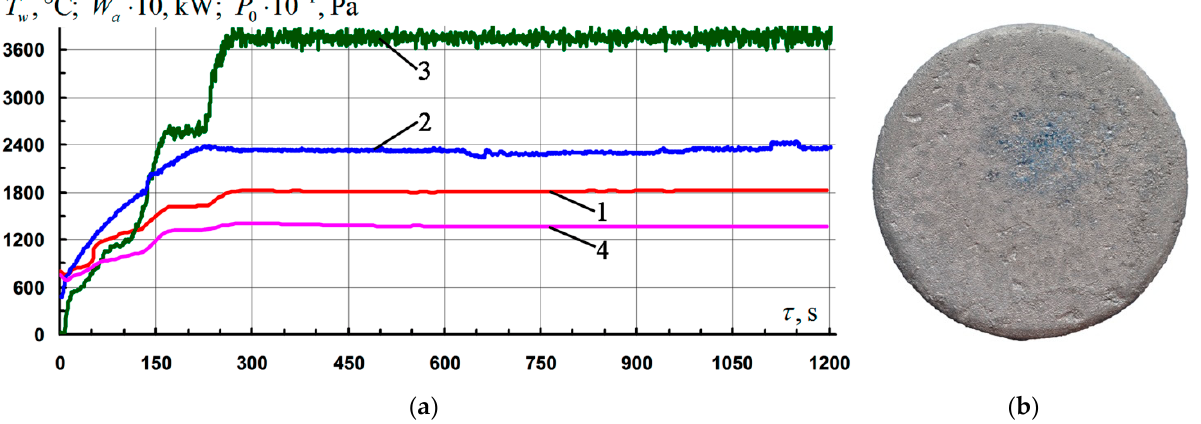
Figure 4. Results of gas-dynamic tests of C f /C–SiC samples coated with the Si–TiSi 2 –MoSi 2 –TiB 2 –CaSi 2 system at T w = 1810–1820 °C: ( a ) change of mode parameters in time: 1, 4—temperature of the front/rear surface of the sample at the critical point, T w ; 2—generator power, W a ; 3 — braking pressure in the pre-heater chamber, P 0 ; ( b ) a typical view of the front side of the samples after testing.